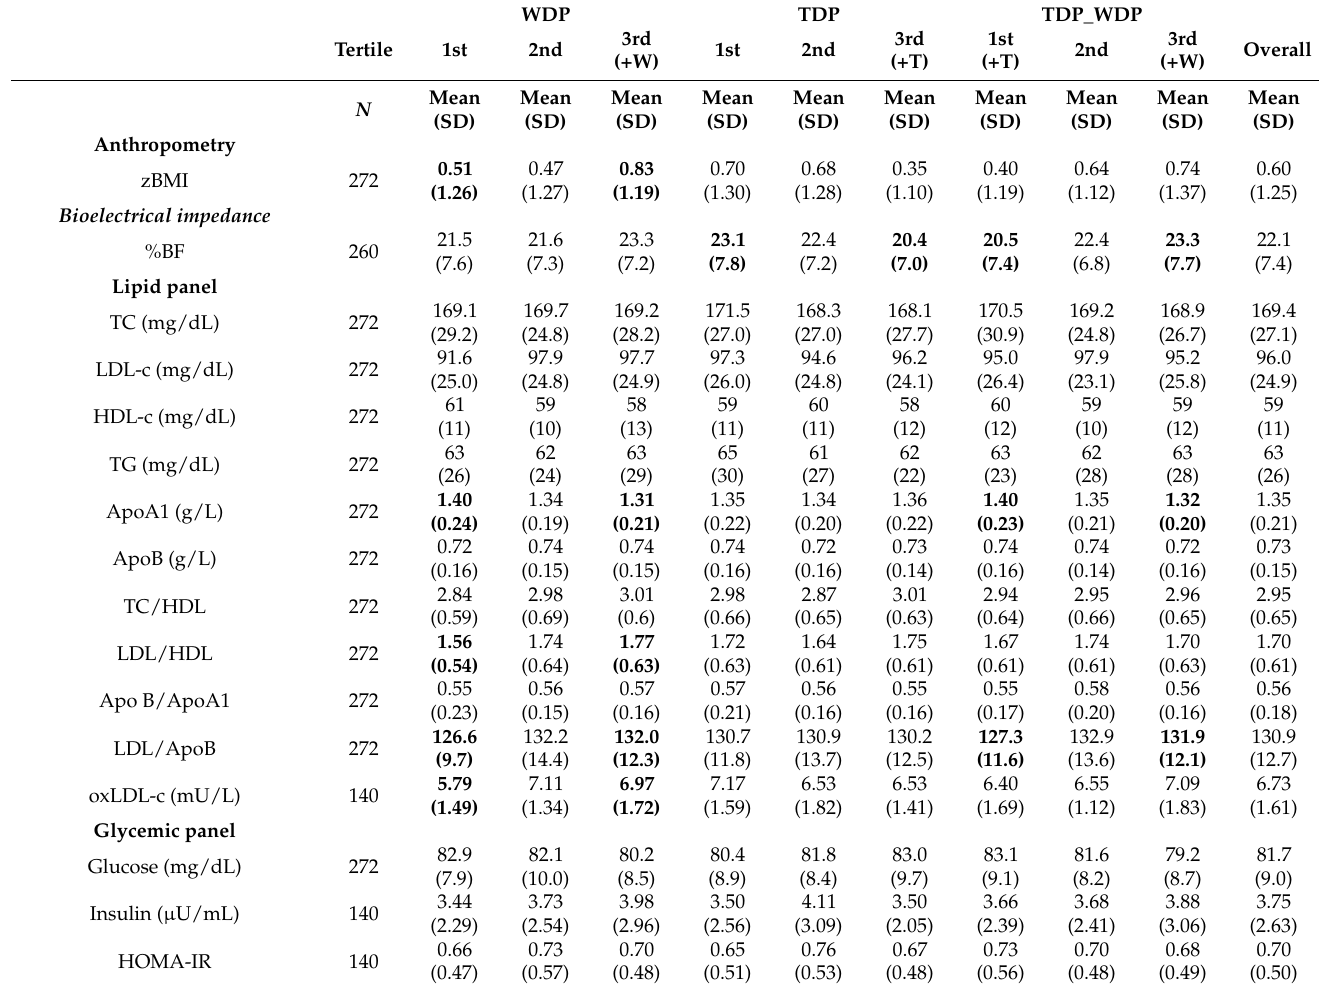
Table 4. Mean (SD) descriptive results by diet pattern scores ascending